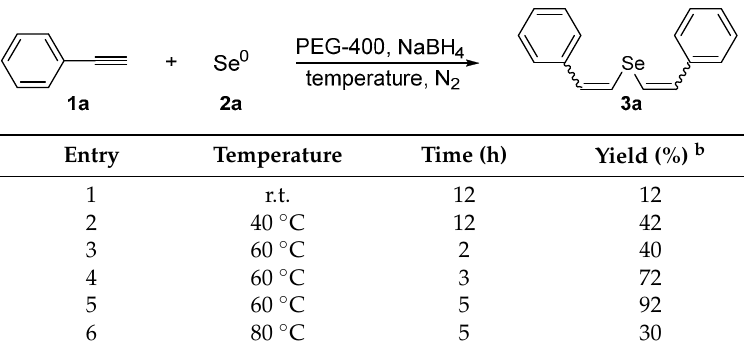
Table 1. Optimization of the synthesis of divinyl selenide 3a a .